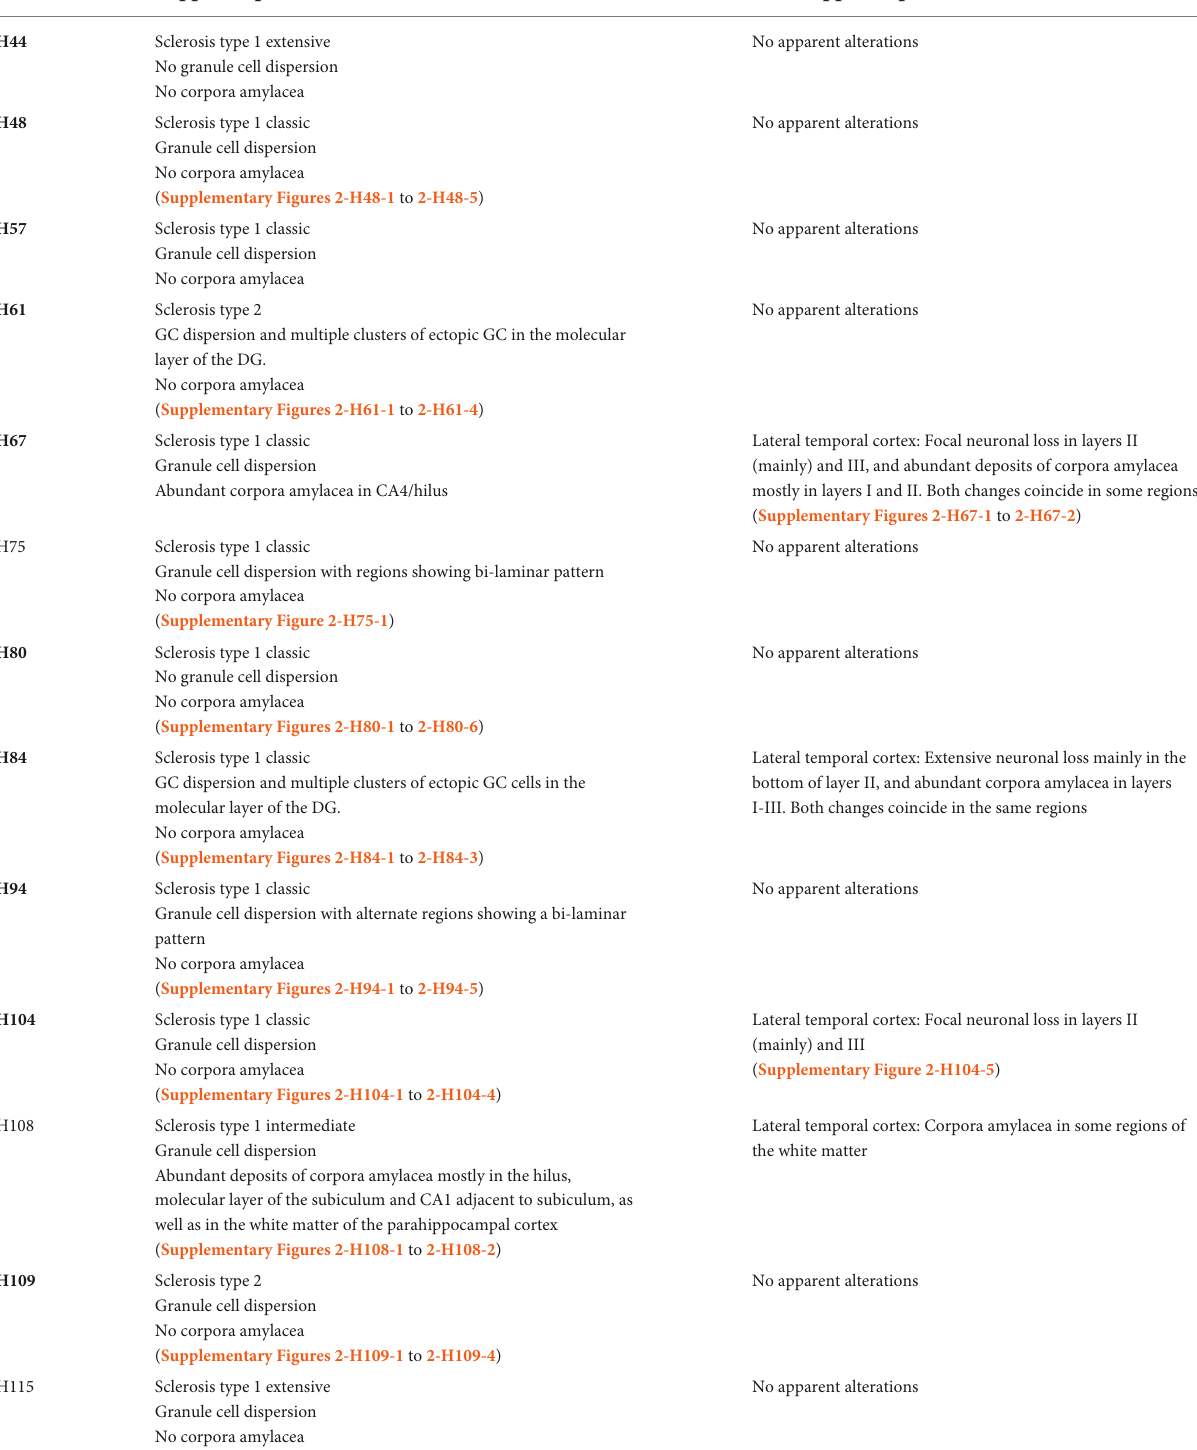
TABLE 3 Histopathological findings detected in biopsy tissue from epileptic patients. Pathology includes hippocampal sclerosis, classified according to ILAE (2013; Blümcke et al., 2013) criteria; alterations in the lamination of the DG (granular cell dispersion, bi-layered, or patchy distortions) and presence of corpora amylacea